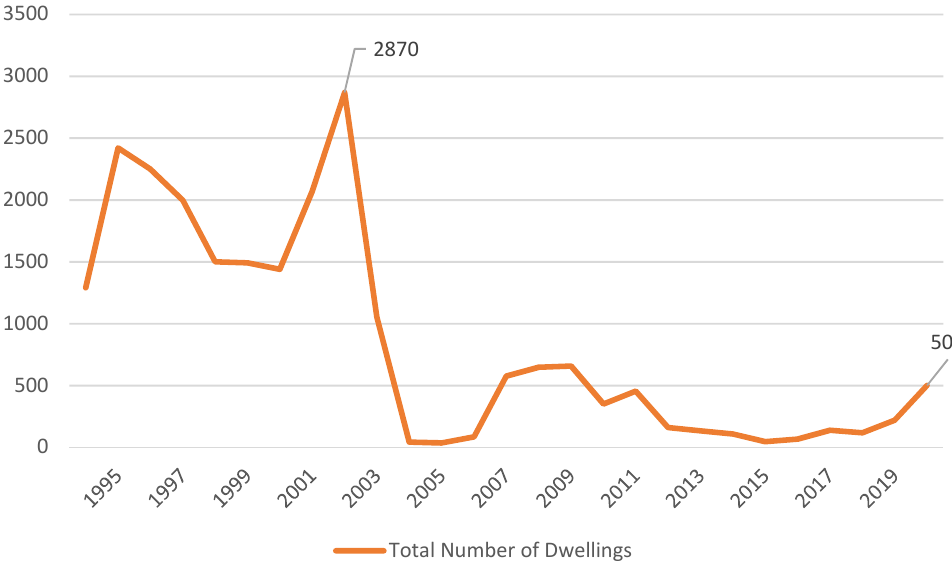
Figure 1. Number of dwellings and households in the city of Lisbon. Source (C â mara Municipal de Lisboa (CML) 2022).